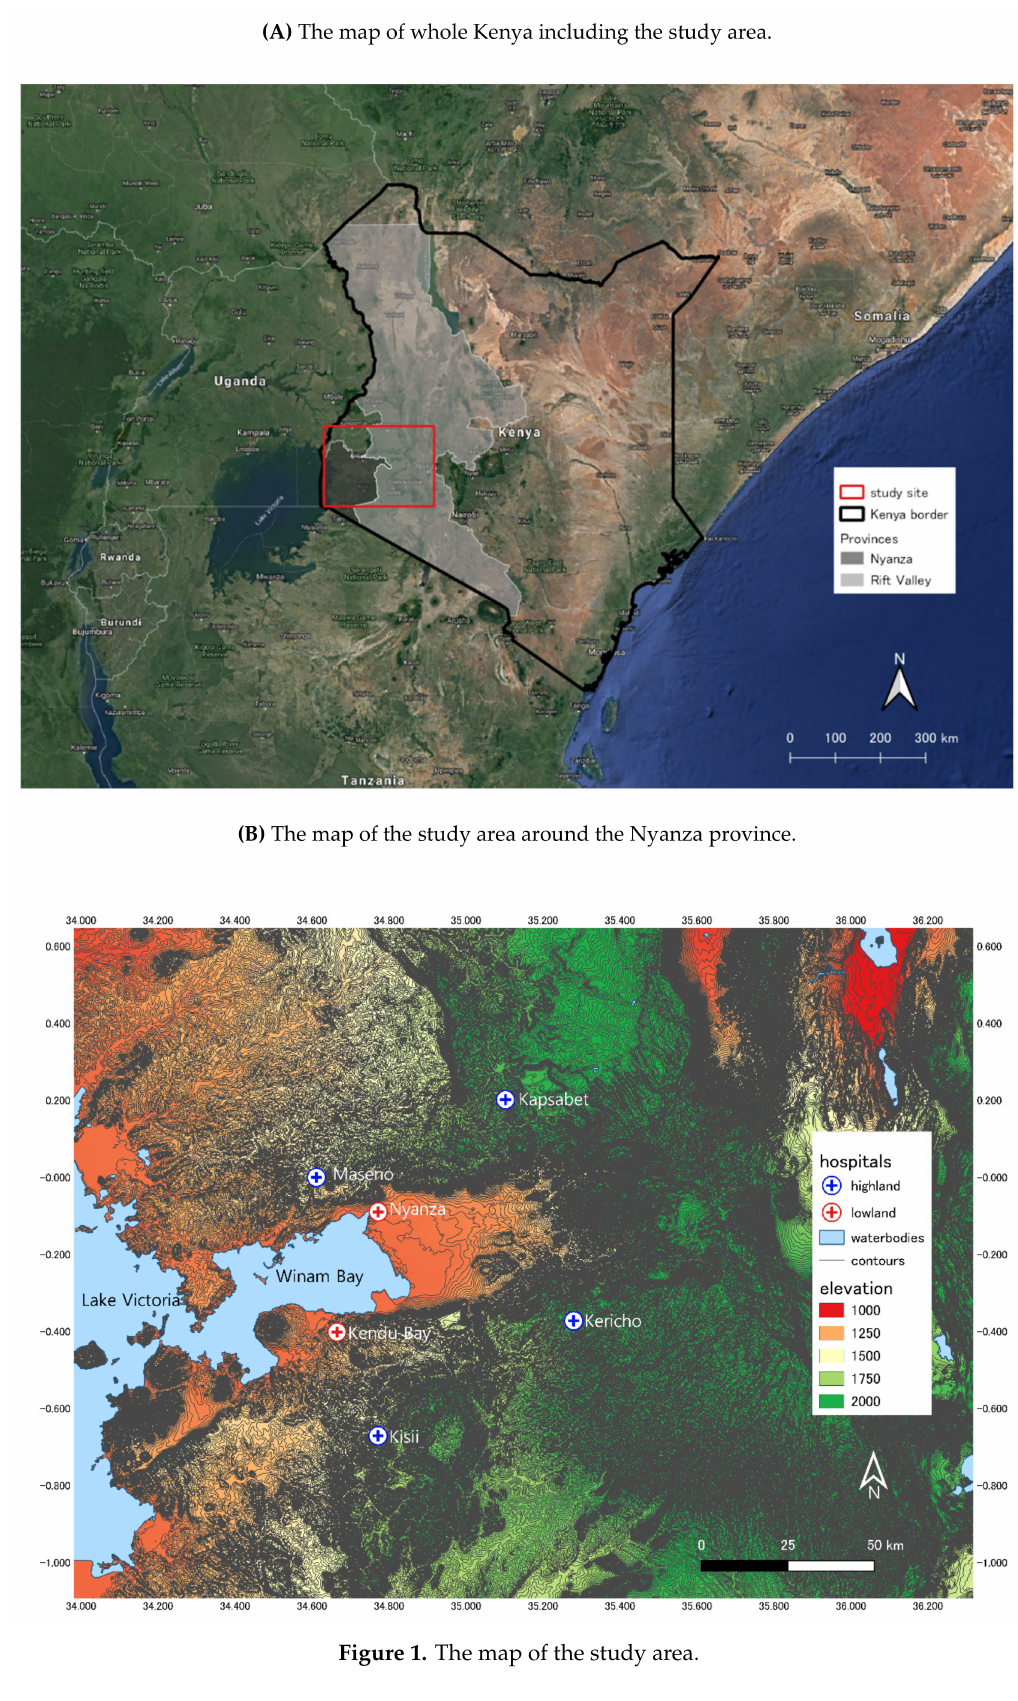
Figure 1. The map of the study